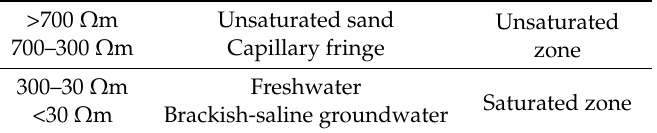
Table 1. Resistivity intervals ( Ω m) adopted to classify the hydrological units.